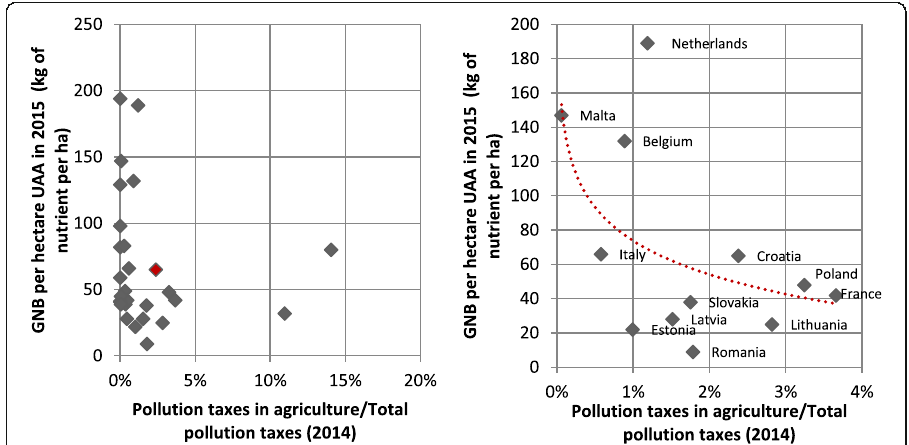
Fig. 5 GNB (2015) vs Environmental Taxes on Agricultural Pollution (2014). (Source: Eurostat (2018b) Agri- environmental indicators, Pressures and risks - Gross Nutrient Balance, Eurostat (2018a). Environmental taxes by economic activity (NACE Rev.